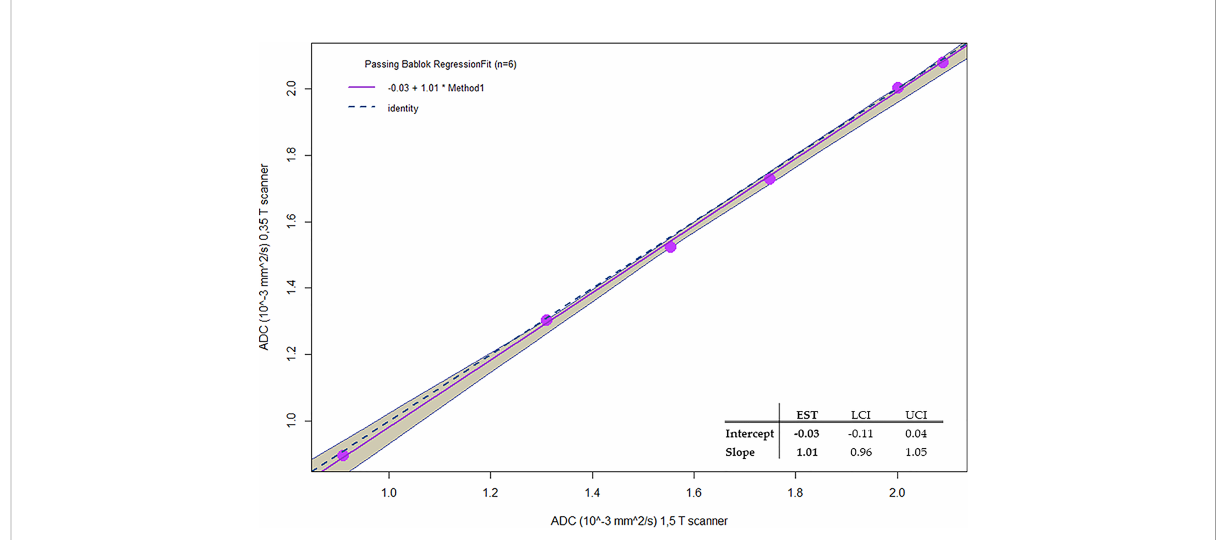
FIGURE 7 Passing-Bablok regression for comparison of ADC values of Methylcellulose concentrations for 1.5 T and 0.35 T